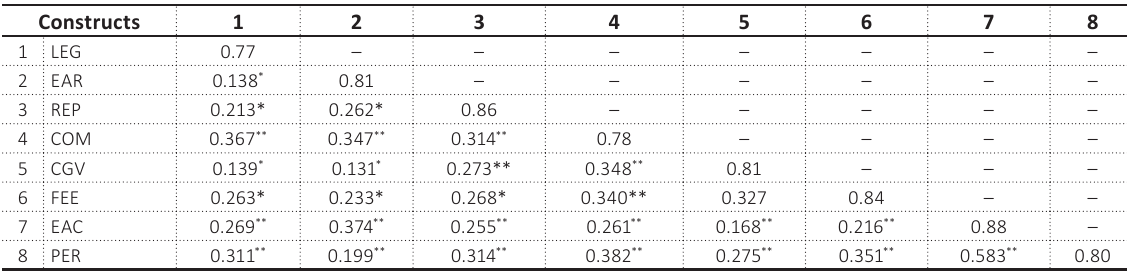
Table 4. Discriminant reliability